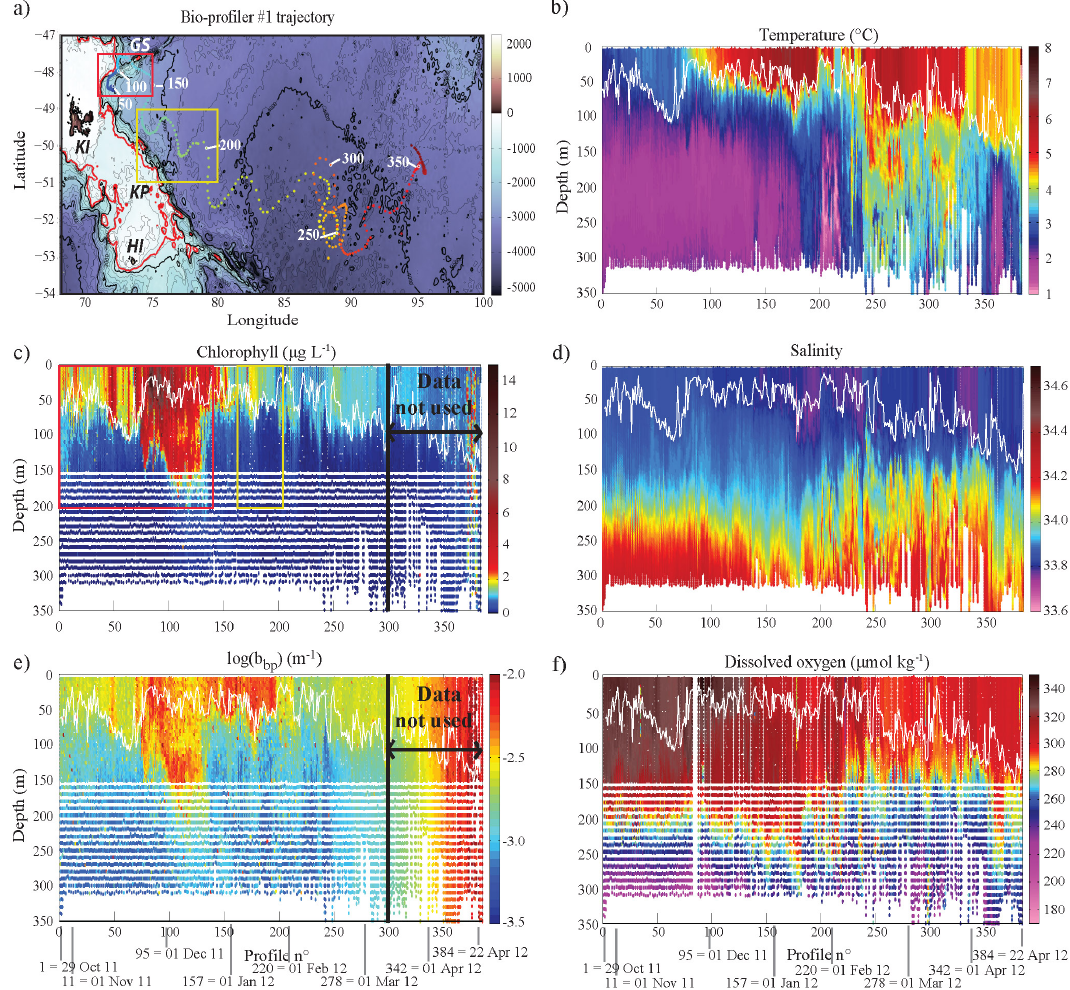
Figure 3. Bio-profiler #1 observations. (a) Bio-profiler #1 trajectory over the bathymetry, with each point representing a depth profile and the colour of the points changing from blue to red over time (dates are shown below the bottom plots). The 700m isobath is represented by the red line contour. KI: Kerguelen Islands; KP: Kerguelen Plateau; HI: Heard Island; GS: Gallieni Spur. (b–f) Evolution of hydrological parameters along the float trajectory: (b) temperature ( ◦ C), (c) chlorophyll (µgL − 1 ) , (d) salinity (unitless), (e) particulate backscattering ( b bp ; log scale; m − 1 ) , and (f) dissolved oxygen (µmolkg − 1 ) . The white line represents the mixed layer depth. Red and yellow rectangles refer to areas of high and moderate chlorophyll used in Fig. 10 and discussed in Sect.